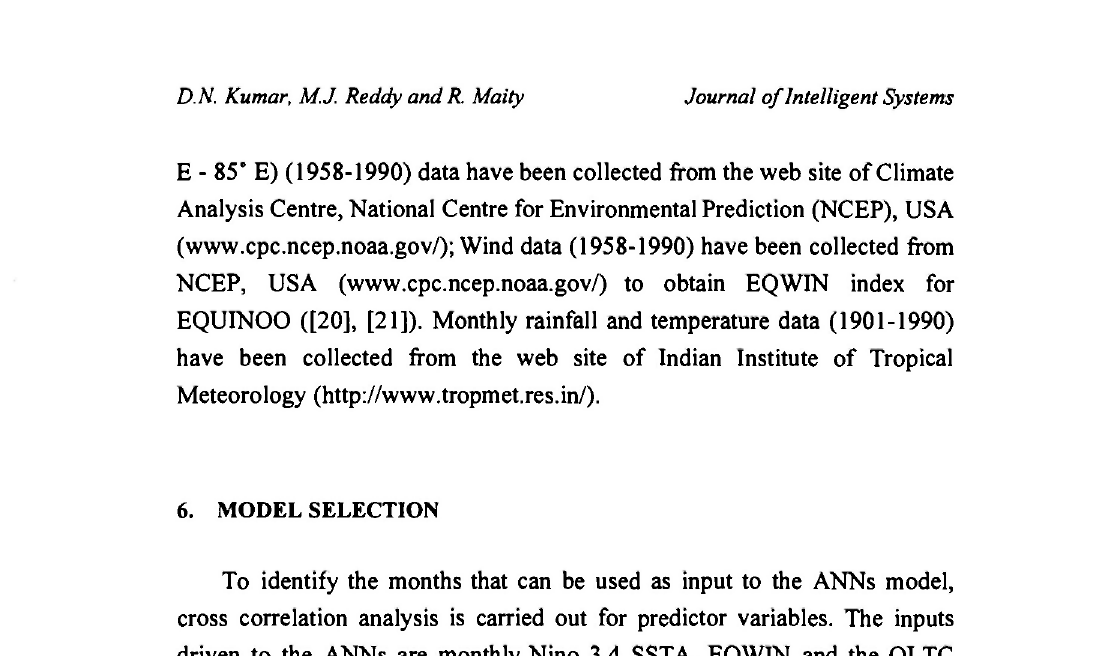
Climate indices of predictor variables considered for rainfall prediction of June, July, August, September months and for summer monsoon (JJAS)